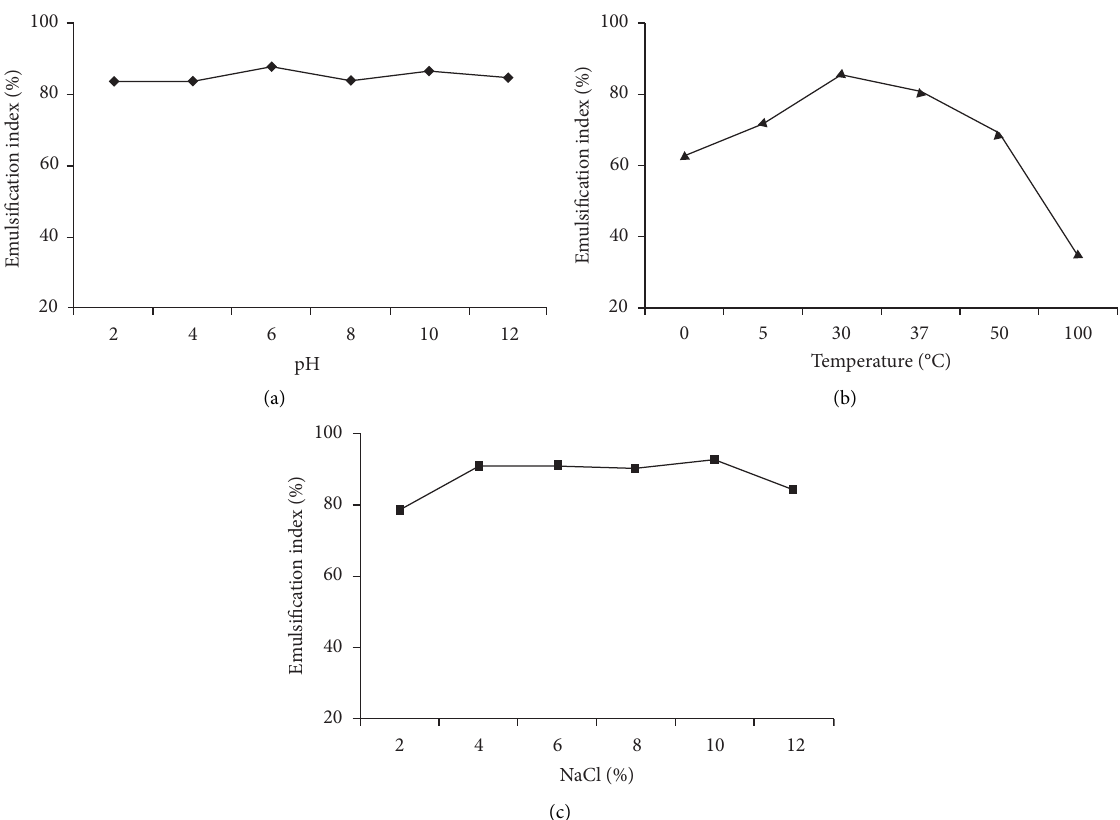
Figure 2: Stability of the bioemulsifier produced by S. maltophilia UCP 1601 against different values of pH (a), temperature (b), and small decrease in salinity concentrations